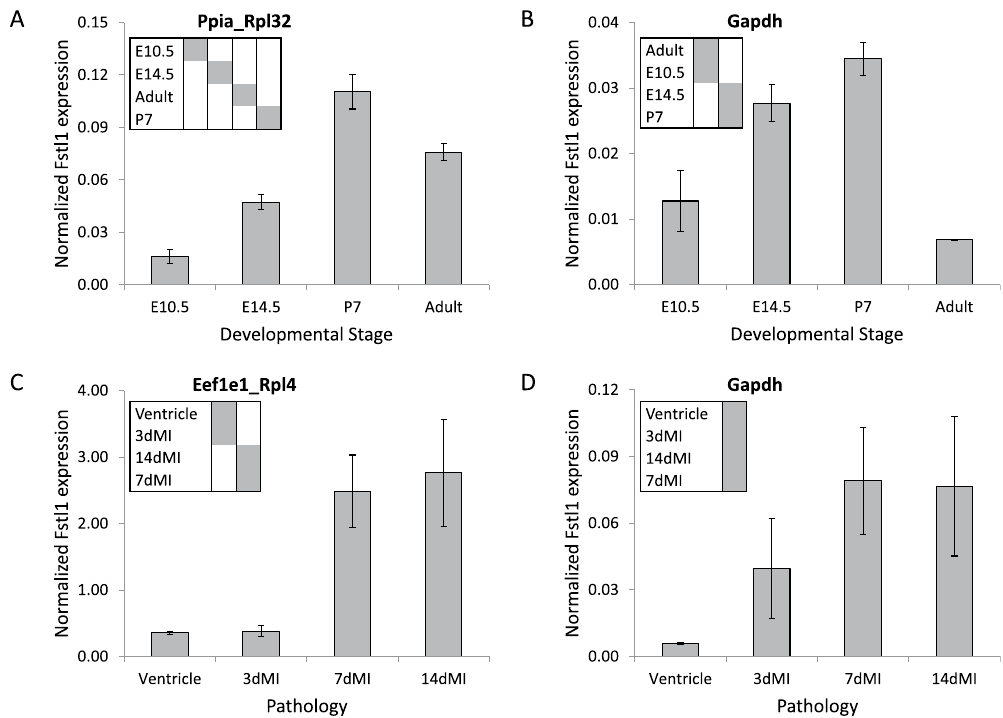
Figure 1. Effects of different normalization strategies on observed Fstl1 expression. Fstl1 expression in whole heart during development (embryonic day 10.5 and 14.5, postnatal day 7 and adult mouse) was determined with qPCR using Ppia and Rpl32 ( A ) or Gapdh as reference genes for normalization ( B ). Fstl1 expression in the normal left ventricle and at different days after induced myocardial infarction (MI) using Eef1e1 and Rpl4 ( C ) or Gapdh ( D ) as reference genes for normalization. The normalized Follistatin-like 1 expression differs significantly between groups (one-way ANOVA). The insets show the result of the subsequent multiple comparison between groups. Grey boxes indicate subsets of groups with absence of evidence for differential expression (p-value < 0.05) according the Student-Newman-Keuls